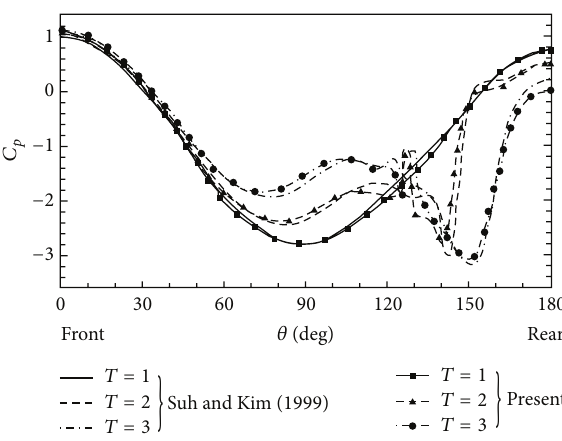
Figure 13: Surface pressure distribution at several instants for Re = 9500 compared with numerical results of Suh and Kim (1999)